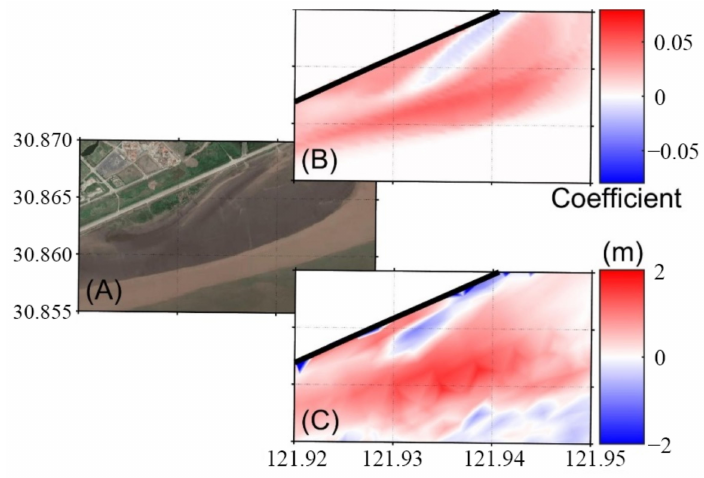
Figure 13. ( A ) The satellite image. ( B ) The first spatial mode of the EOF results; and ( C ) the differences between the topography field measurements in 2015 and 2019 (2019 vs. 2015), where the red and blue represent accretion and